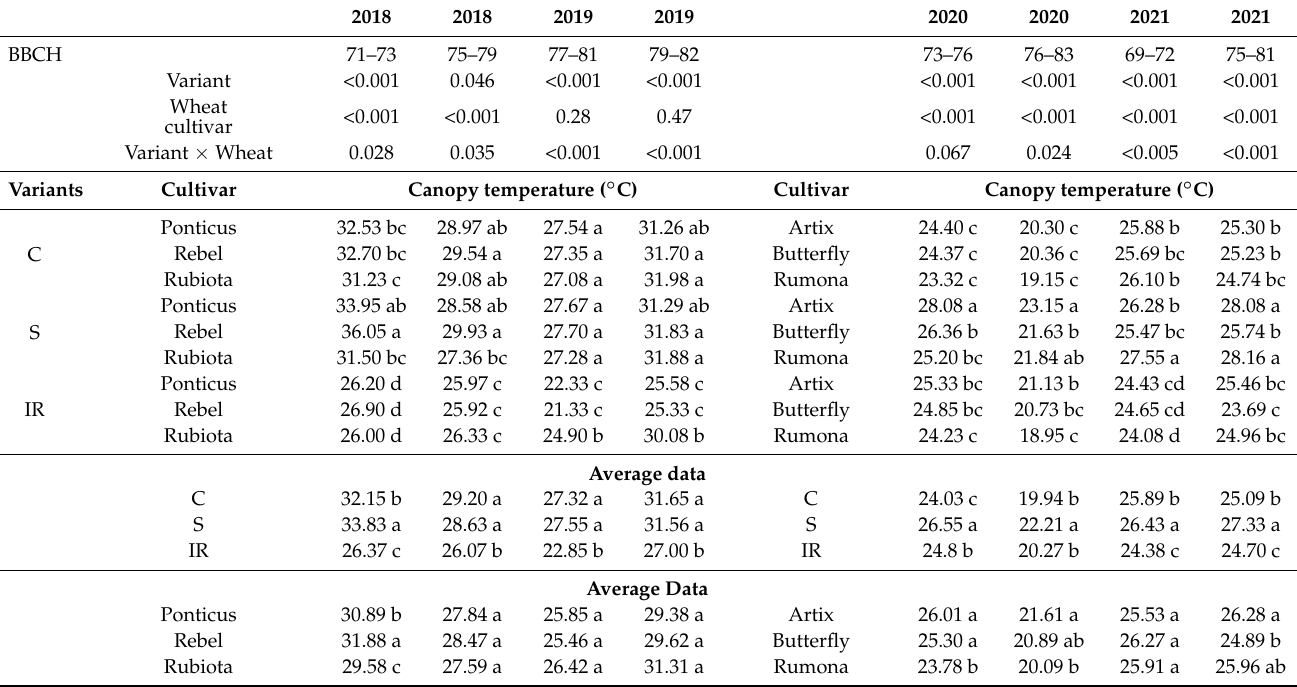
Table 4. Results of the analysis of the variance of the wheat growth